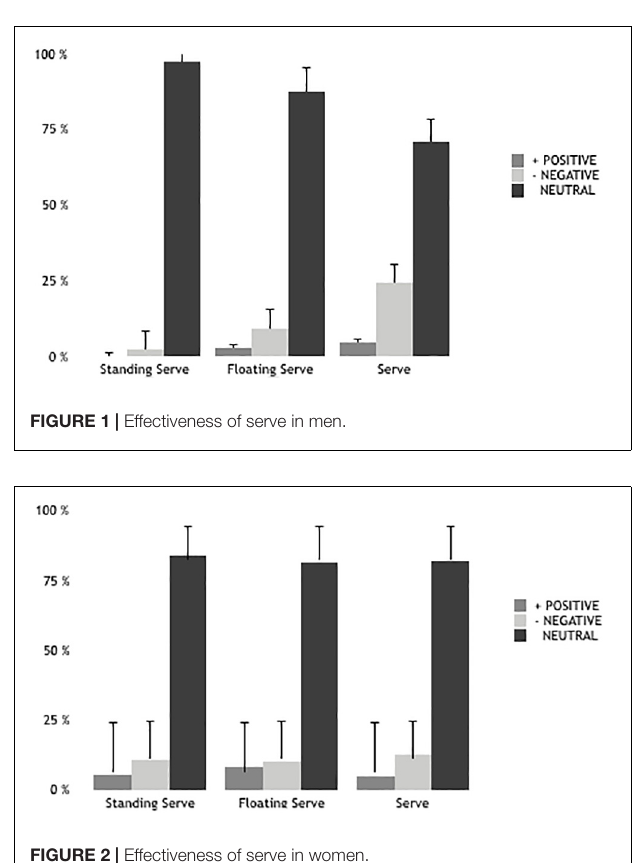
FIGURE 2 | Effectiveness of serve in women.